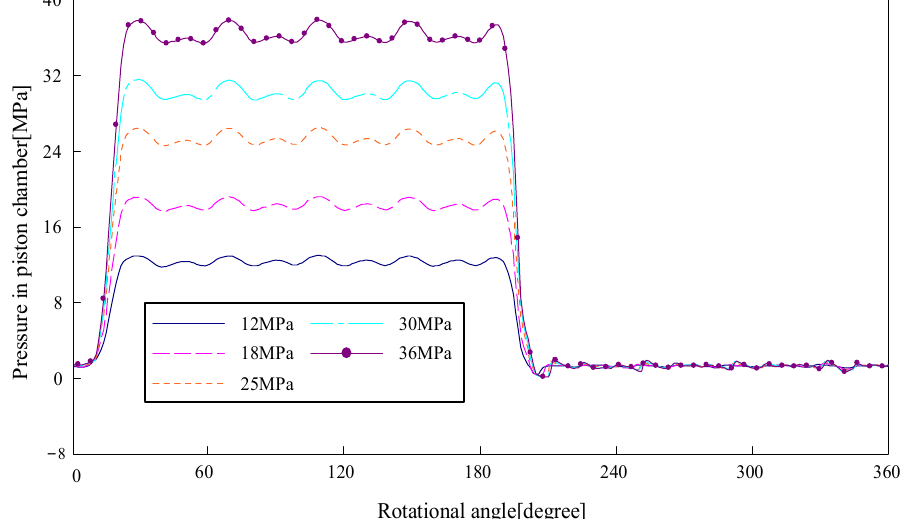
Figure 17. Pressure in the piston chamber with different rotational speeds at the beginning of the suction phase.